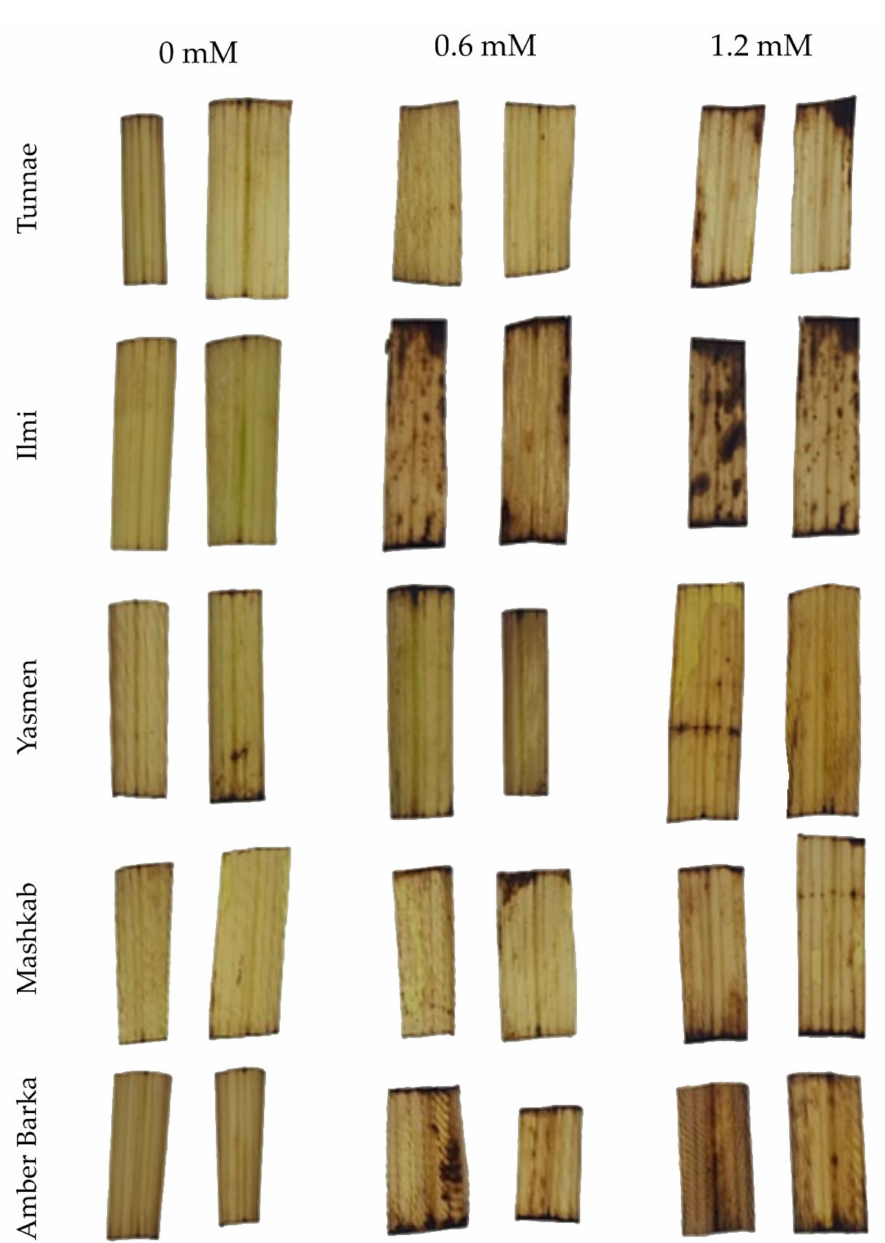
Figure 4. Detection of hydrogen peroxide (H 2 O 2 ) accumulation in response to lead (Pb)-induced oxidative stress. Upon stress induction, different sorts of reactive oxygen species (ROS)